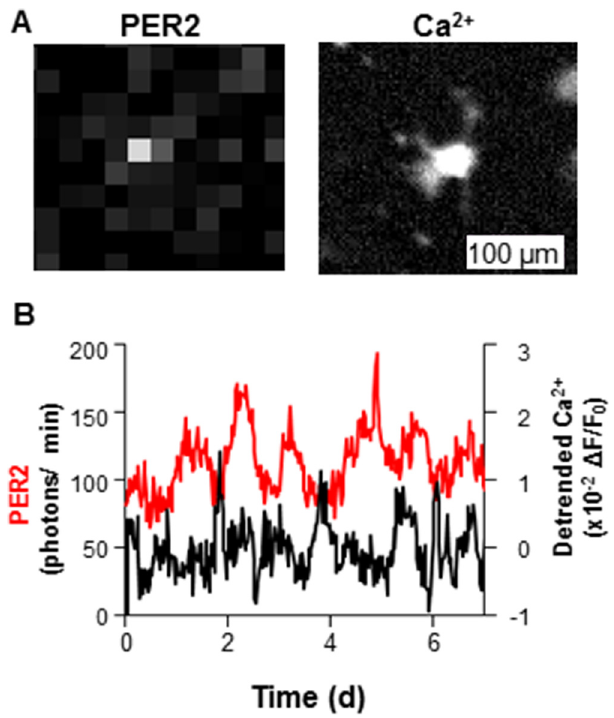
Fig 4. Simultaneous monitoring of basal Ca 2+ and PER2 levels in dispersed cardiomyocytes. (A) Representative PER2::LUC (left) and GCaMP3 (right) images of a single cardiomyocyte in dispersed culture. (B) Patterns of Ca 2+ (GCaMP3, black) and PER2 (PER2::LUC, red) of the cardiomyocyte shown in a recorded over